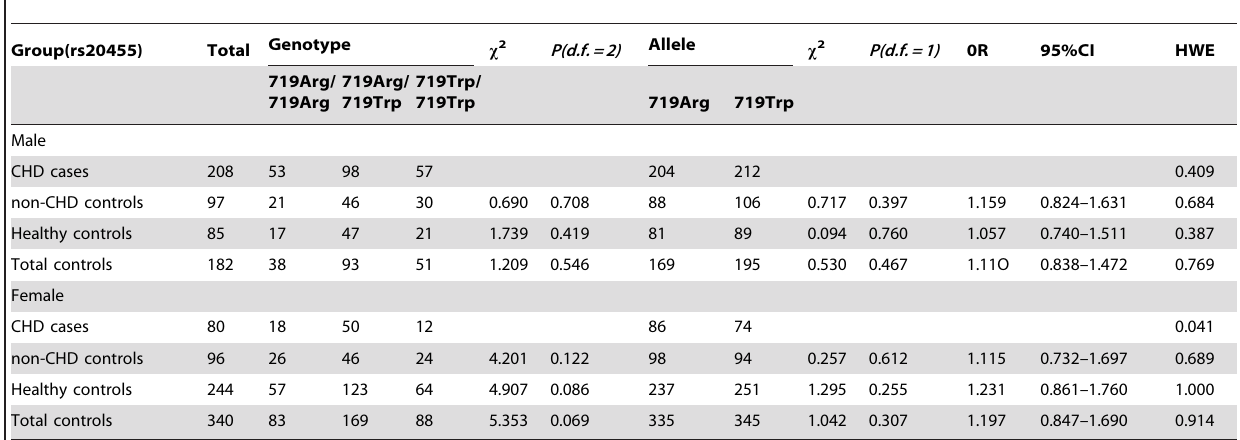
Table 2. Genotype and allele of Trp719Arg in male and female